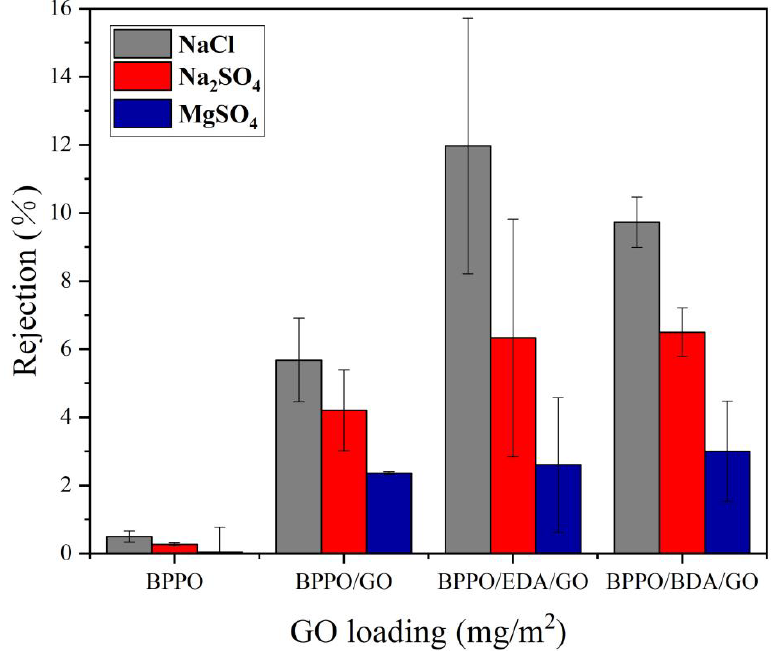
Figure 7. Influence of BPPO/ AX-GO-modified nanofiltration membranes on rejection rates.